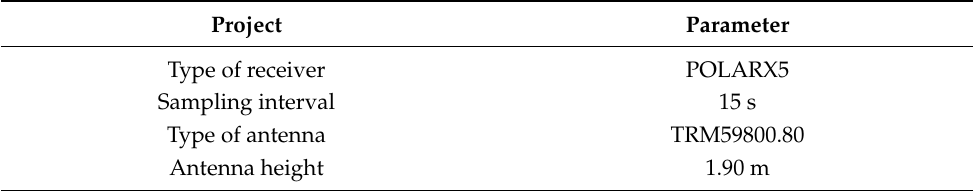
Table 1. Receiver and its related parameters at the P041 site.